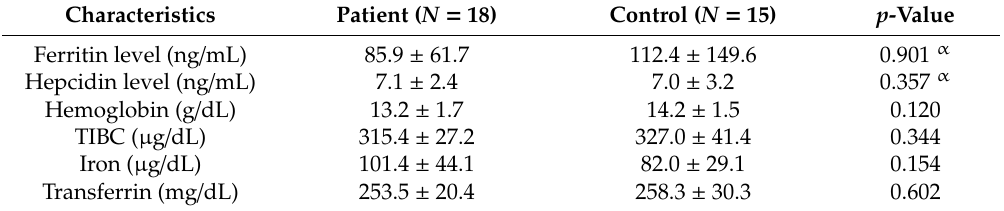
Table 2. The di ff erence in iron profiles including hepcidin between RLS patients and the control group.